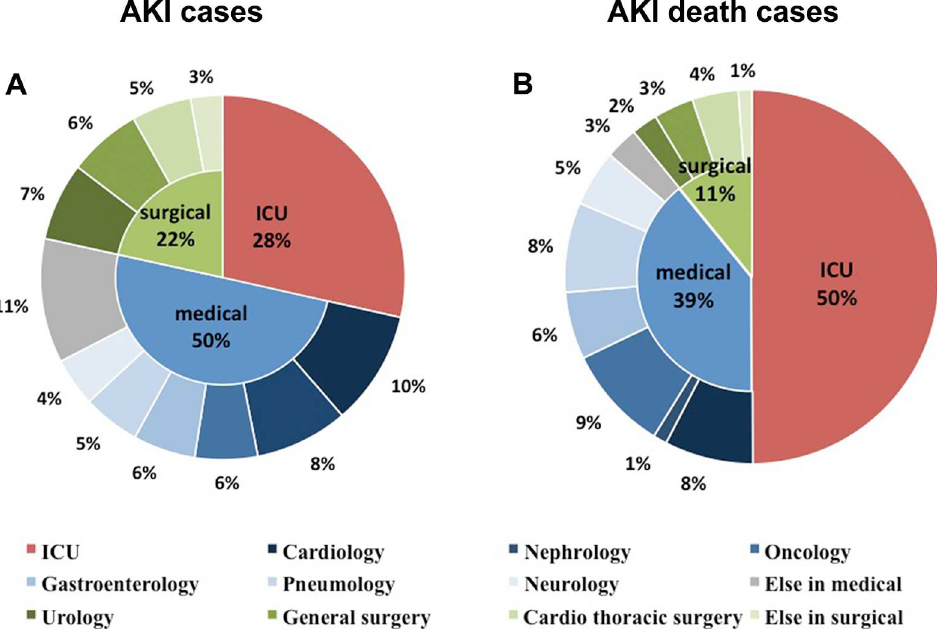
Fig 1. The distribution of AKI cases and AKI death cases in different clinical departments. Panel A showedthe distributionof AKI cases. Among all the AKI patients, 50% were from medicaldepartments, 29% from ICU and 21% from surgical departments. Panel B displayedthe distribution of AKI death cases. ICU contributed to half of the death